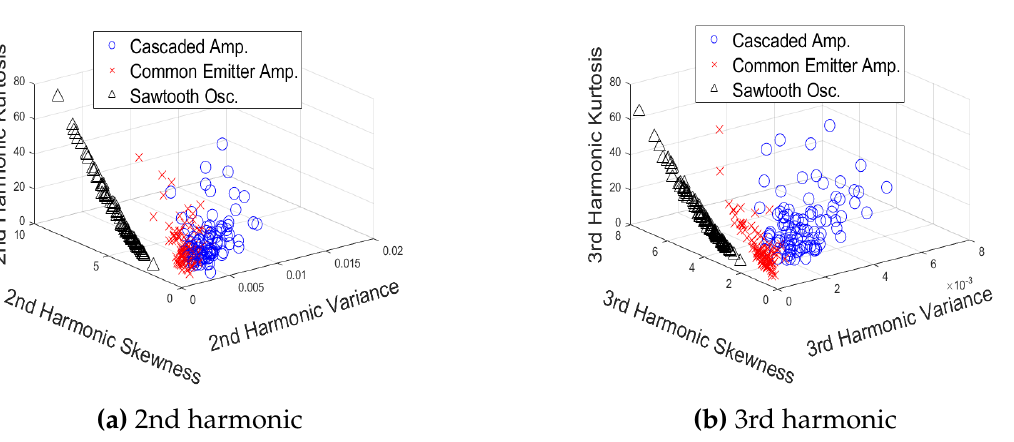
Figure 9. Statistical feature space representation of second and third harmonics data, SNR=2 dB.